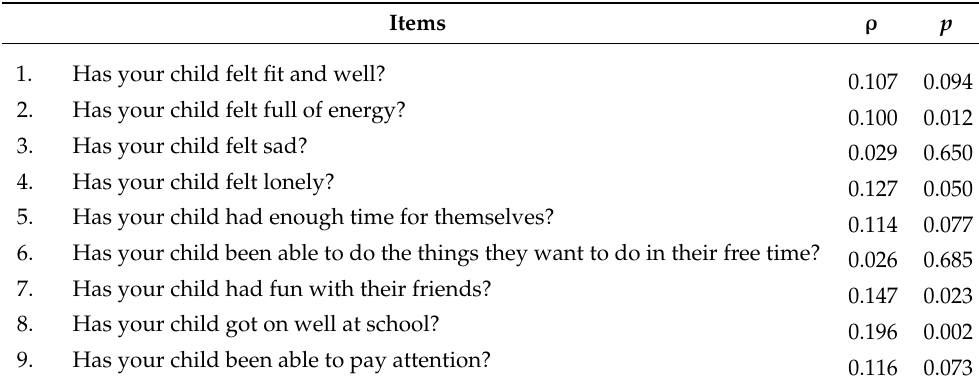
Table 4. Kidscreen-10 Index modified proxy for the Eurobarometer and the physical activity frequency in Spanish children and adolescents with